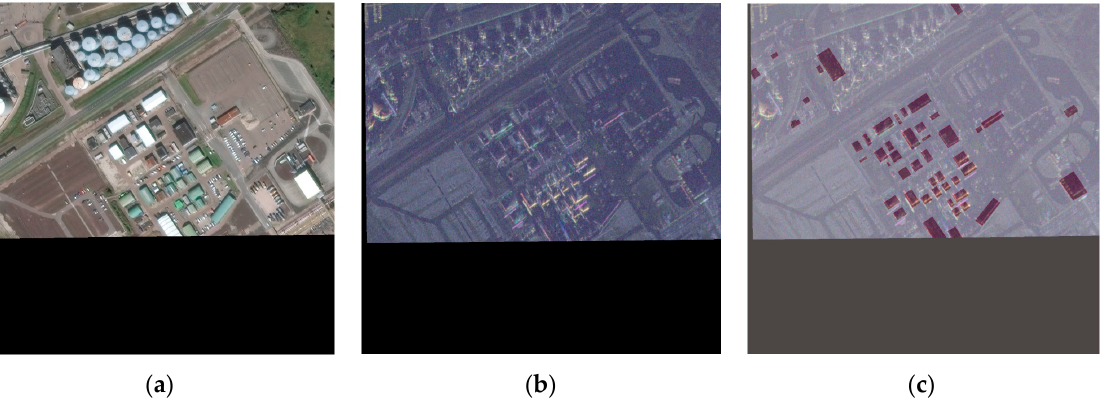
Figure 1. A tile example shows a pair of ( a ) optical RGB and ( b ) SAR shown as false-colored (R = HH, G = VV, B = VH) over a small oil storage area. ( c ) shows the building footprints overlayed on top of the false-colored SAR. One main challenge of this dataset is differentiating patterns of buildings against objects with high backscatter intensity (such as containers, oil silos, and ships) in the port